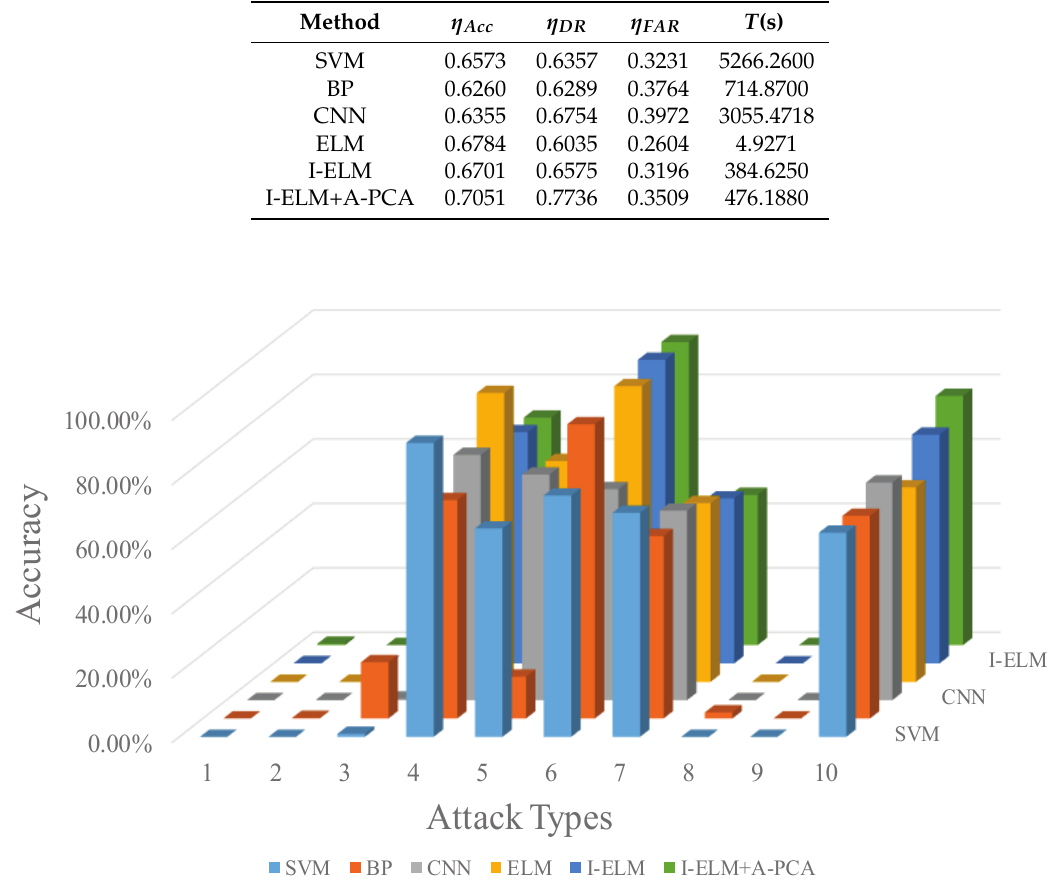
Figure 8. The confusion matrices analysis of different methods